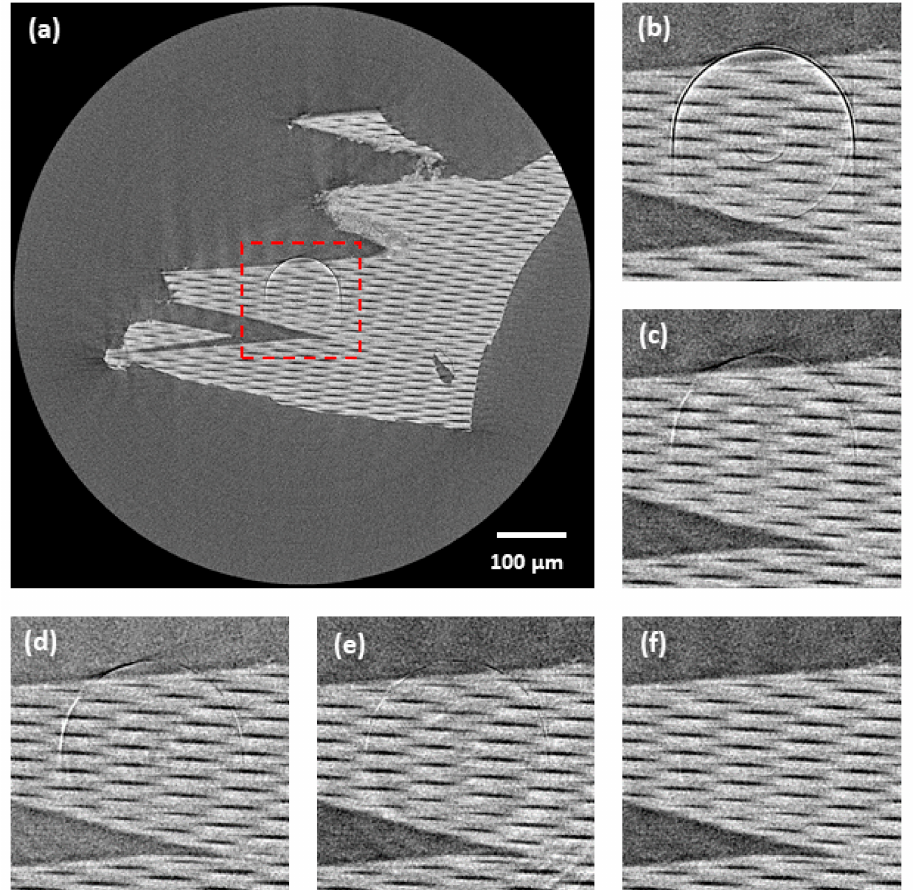
Figure 11. Comparison of tomograms after ring artifacts reduction by tested methods—real computed tomography (CT) data of glass capillary array acquired with a CCD-based camera: ( a ) original tomogram (without any correction)—red labelled area marks central area visualized in following images; ( b ) original; ( c ) M1; ( d ) M2; ( e ) M3; ( f ) proposed. For visualization, the same contrast setting was used for all the images.